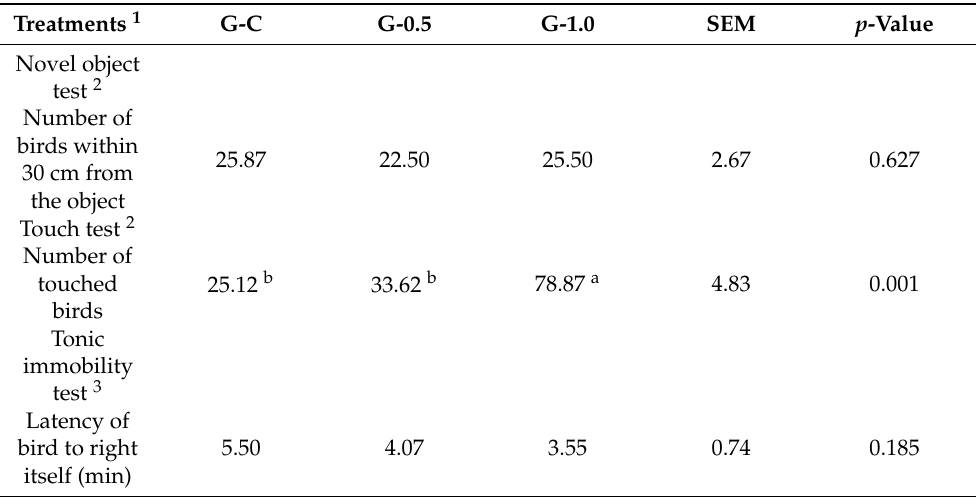
Table 2. Effect of the dietary synbiotic supplementation on the novel object, touch, and tonic immobility tests of heat-stressed broiler chickens.